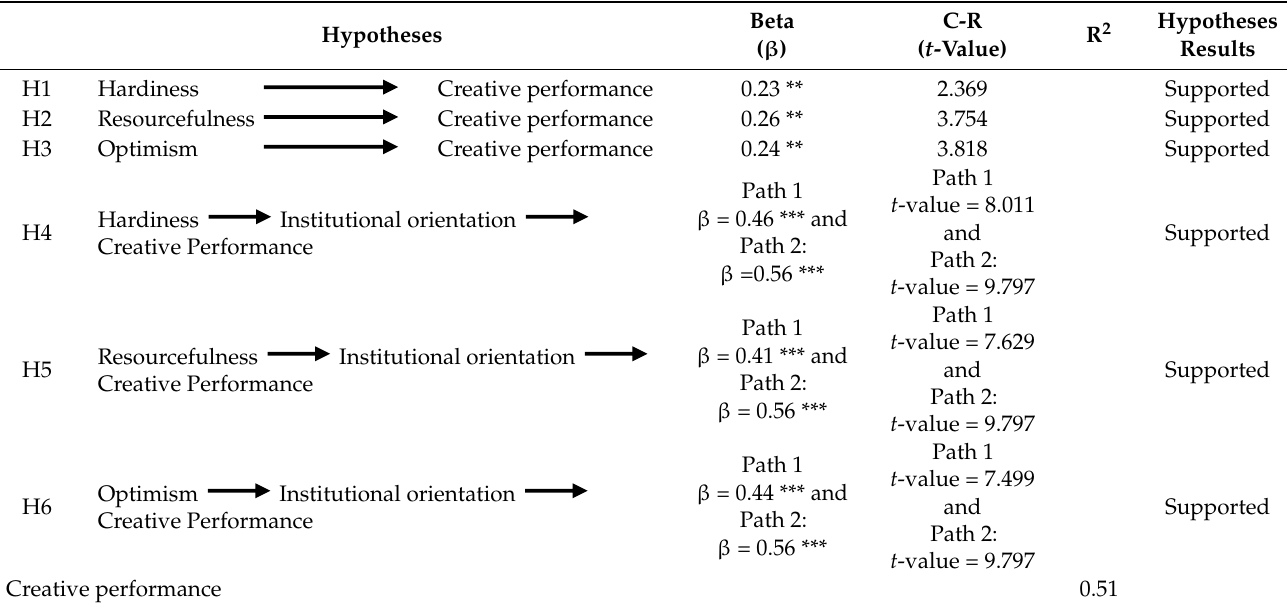
Table 5. The results of the structural model.